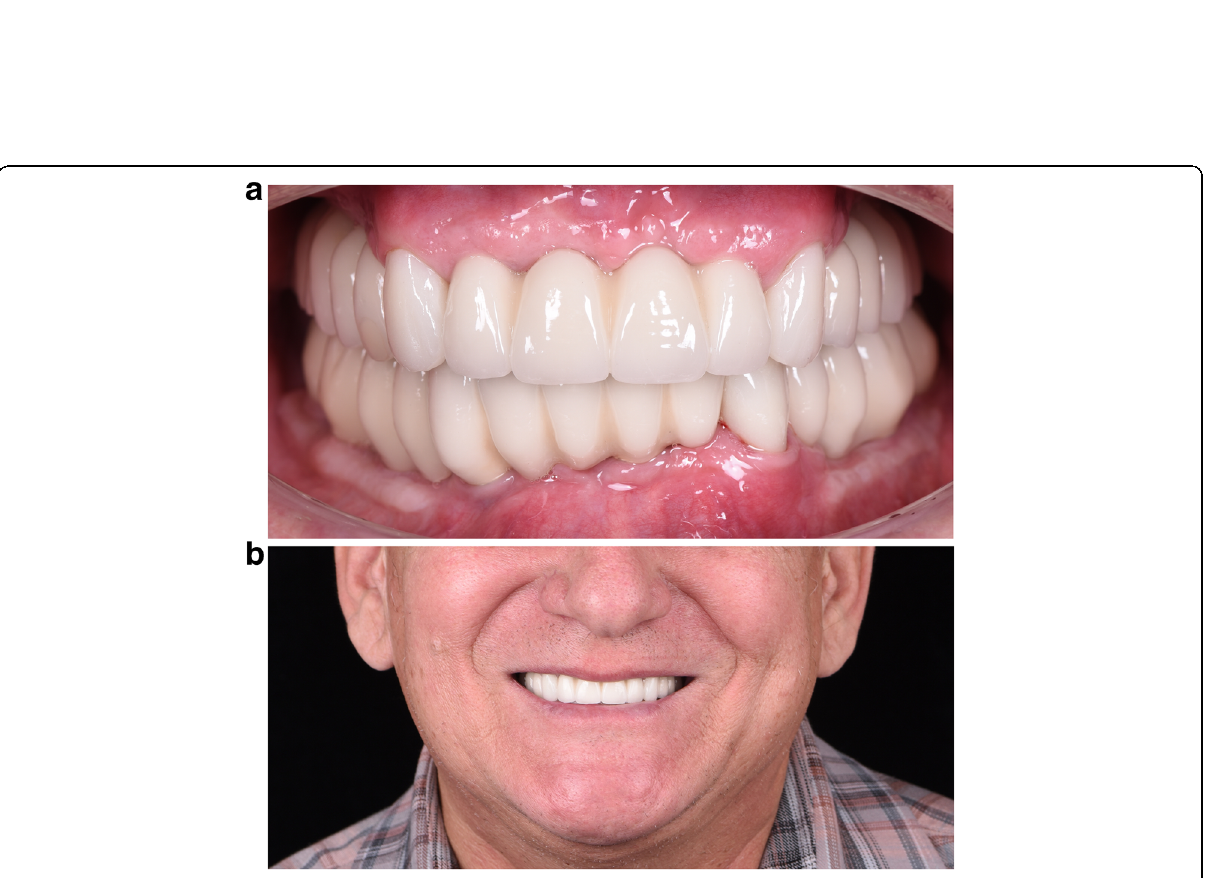
Fig. 11 a , b Final result (Prosthodontist: Evgeniy